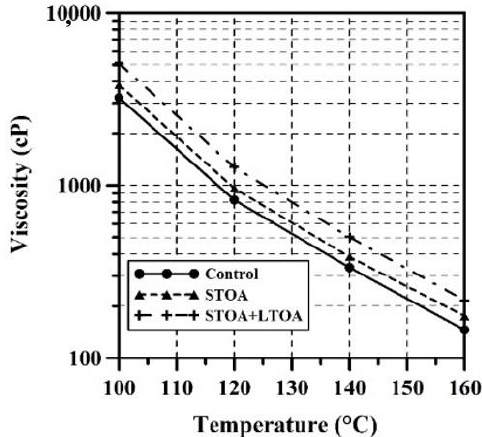
Figure 1. Viscosity curves of unaged AC 60/70 (control) and mixes subjected to aging in RTFOT and RTFOT + PAV.